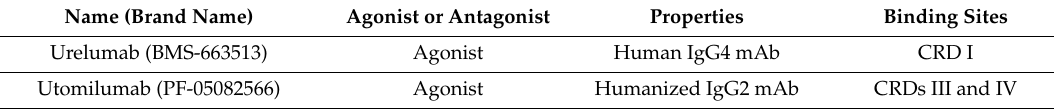
Table 1. The list of anti-CD137 antibodies, their di ff erent properties and binding